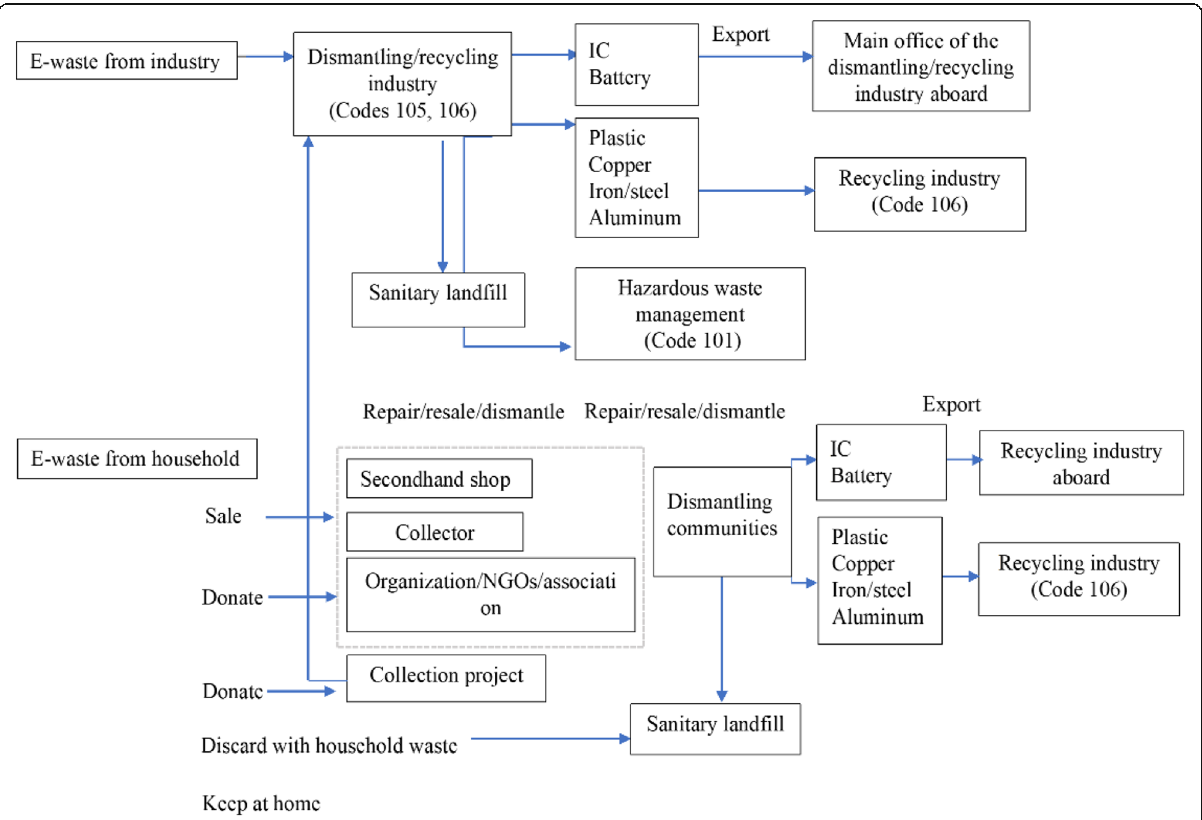
Fig. 1 E-waste flow in Thailand (market